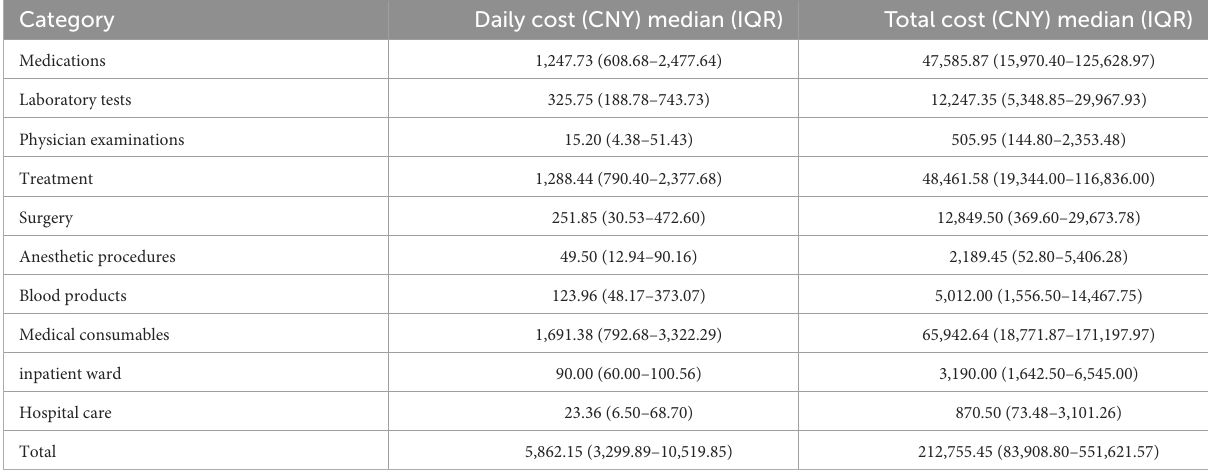
TABLE 3 Median daily cost and total cost distributions of patients classified by